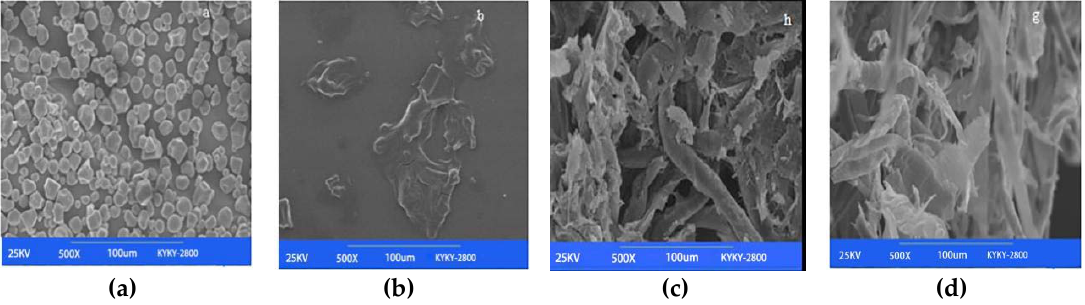
Figure 5. SEM images of starch ( a ); acrylamide ( b ) and GCF ( c , d ).